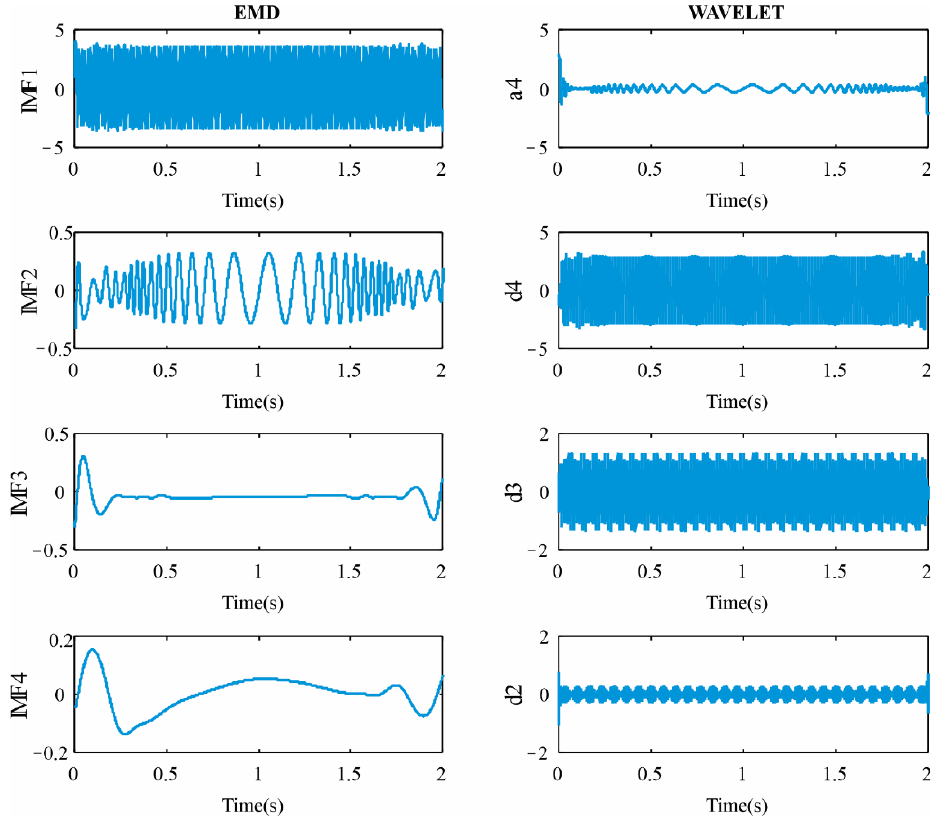
Figure 6. Signal decomposition using EMD and Wavelet.